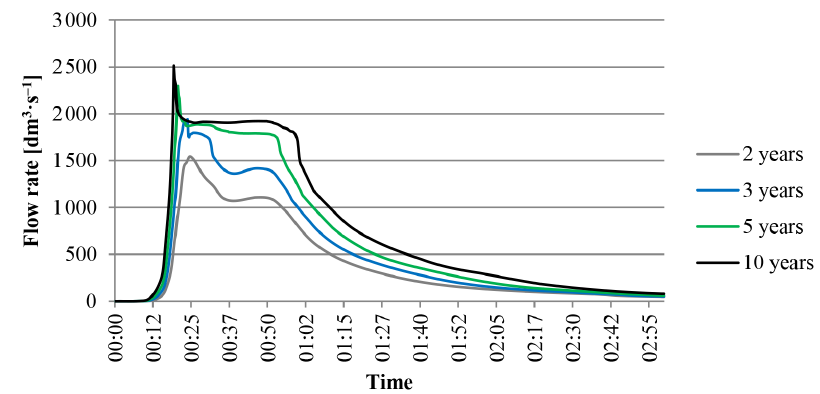
Figure 9. Change in the intensity of flow through channel Link-30 – after the implementation of modernization works